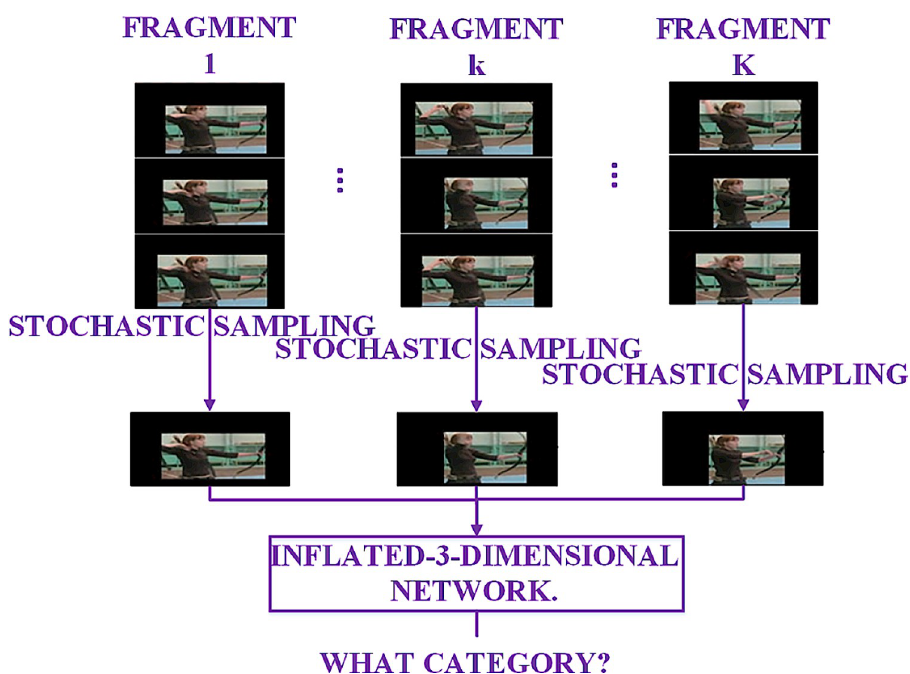
Fig 7. The process of fragment and stochastic sample about